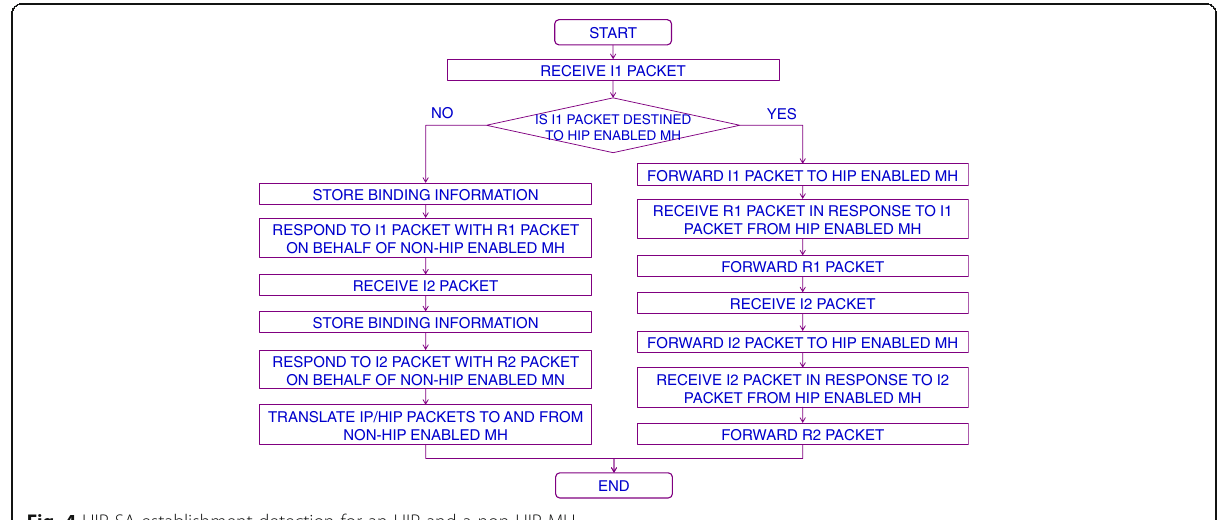
Fig. 4 HIP SA establishment detection for an HIP and a non-HIP MH